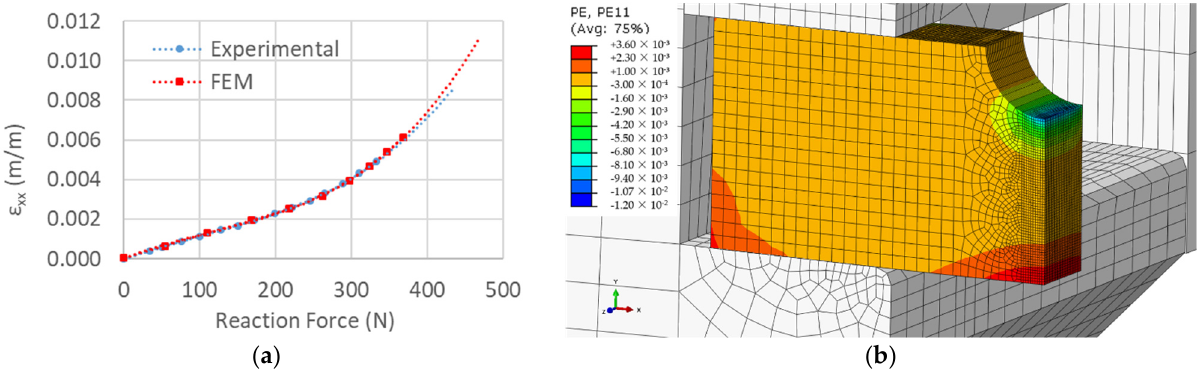
Figure 13. Numerical results: ( a ) Numerical and experimental comparison; ( b ) Normal plastic strain in x-direction, external force of 470 N. Table 4. Parameters used on the calibrated numerical model.